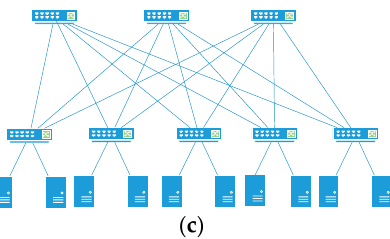
Figure 6. Network topologies under evaluation: ( a ) classical-3-layer ( b ) fat tree ( c ) leaf and spin.